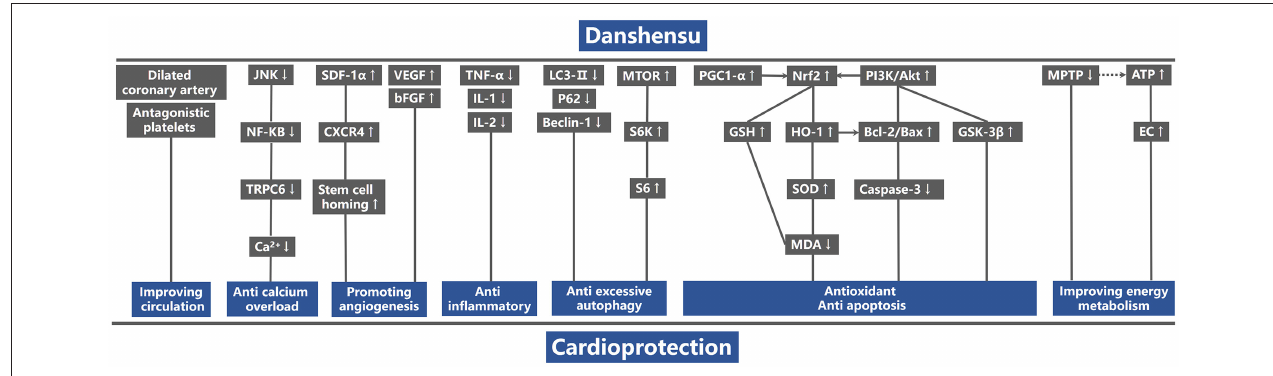
FIGURE 8 | A schematic representation of cardioprotective mechanism of DSS for myocardial ischemic injury. P-Akt, phosphothreonine kinase; P-PI3K, phosphatidylinositol 3-kinase; P-GSK-3 β , phosphorylated gGlycogen synthase kinase-3 beta; PGC1- α , peroxisome proliferator activated receptor γ coactivator-1 α ; Nrf2, nuclear factor erythroid 2-related factor 2; HO-1, heme oxygenase-1; GSH, glutathione synthetase; MDA, malondialdehyde; SOD, superoxide dismutase; Bcl-2, B-cell lymphoma-2; Bax, BCL2-associated X protein; TNF- α , tumor necrosis factor- α ; IL-1, Interleukin-1; IL-6, Interleukin-6; SDF-1 α , stromal cell-derived factor-1 α ; CXCR4, C-X-C chemokine receptor type 4; VEGF, vascular endothelial growth factor; bFGF, basic fibroblast growth factor; P-mTOR, phosphorylated mammalian target of rapamycin; P-S6k1, phosphorylated ribosomal protein S6 kinase beta-1; P-S6, phosphorylated ribosomal protein s6; p62, sequestosome-1; LC3, microtubule-associated protein light chain 3; P-JNK, phosphorylated c-Jun N-terminal kinase; NF-KB, nuclear factor- κ B; TRPC6, transient receptor potential cation channel, subfamily C, member 6; ATP, adenosine triphosphate; EC, energy charge; MPTP, Mitochondrial permeability transition pore. Solid lines indicate established effects, whereas dashed lines represent putative